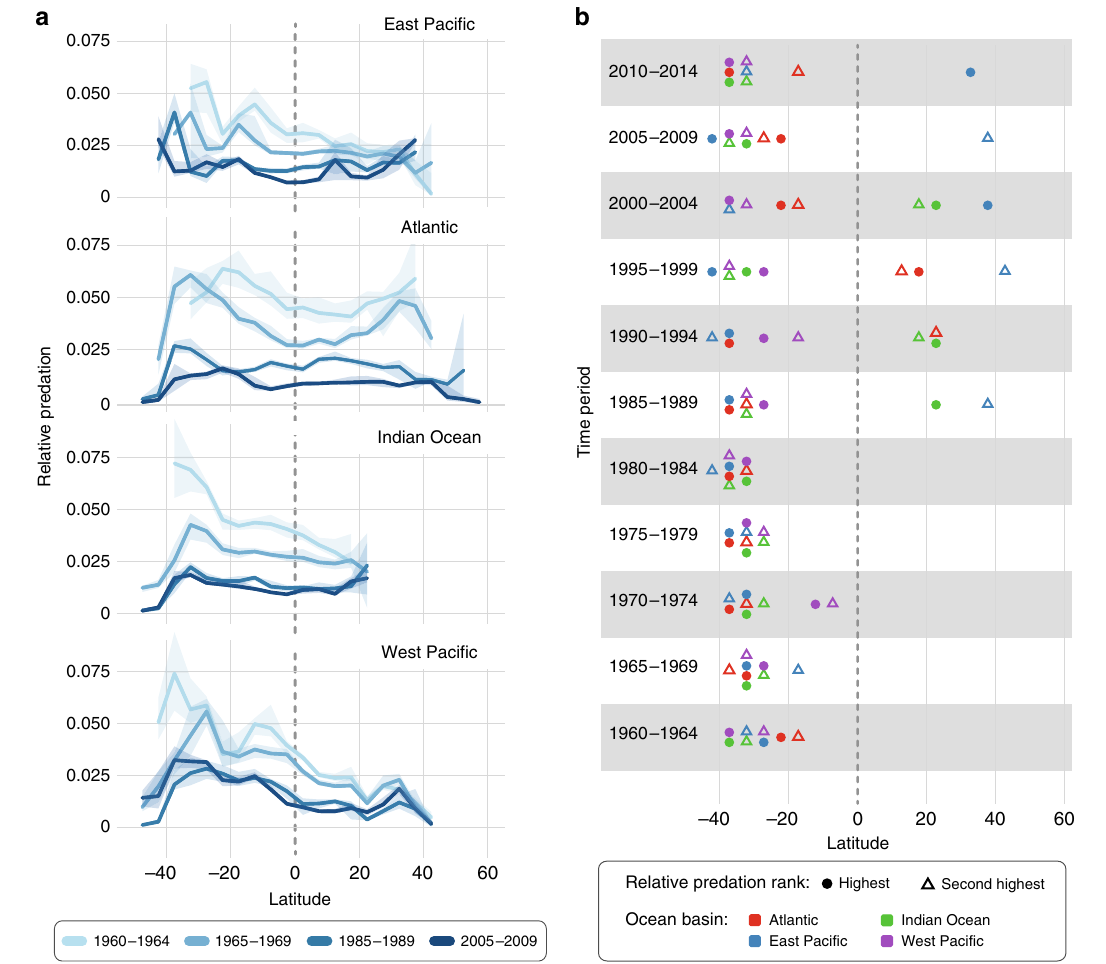
Fig. 2 Temporal patterns of relative predation across latitude. a Median annual relative predation (with non-parametric 95% con fi dence intervals) exerted by pelagic fi sh predators across latitude for four representative 5-year time intervals. b Latitudes with the strongest (dots) and second strongest (triangles) median relative predation per 5-year time interval between 1960 and 2014. Source data are provided in Supplementary Data